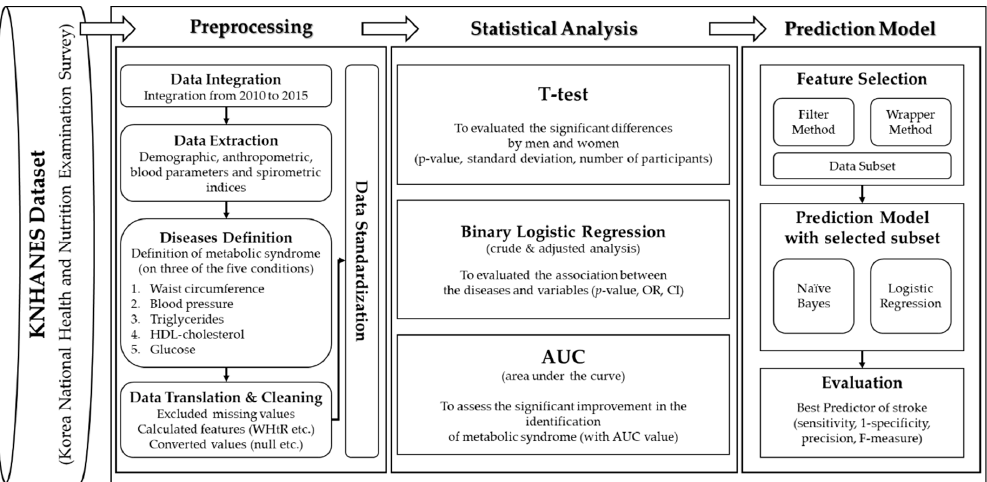
Figure 1. The metabolic syndrome prediction study was designed for preprocessing and statistical analysis. WHtR, waist-to-height ratio; OR, odds ratio; CI, confidence interval. analysis. WHtR, waist-to-height ratio; OR, odds ratio; CI, confidence